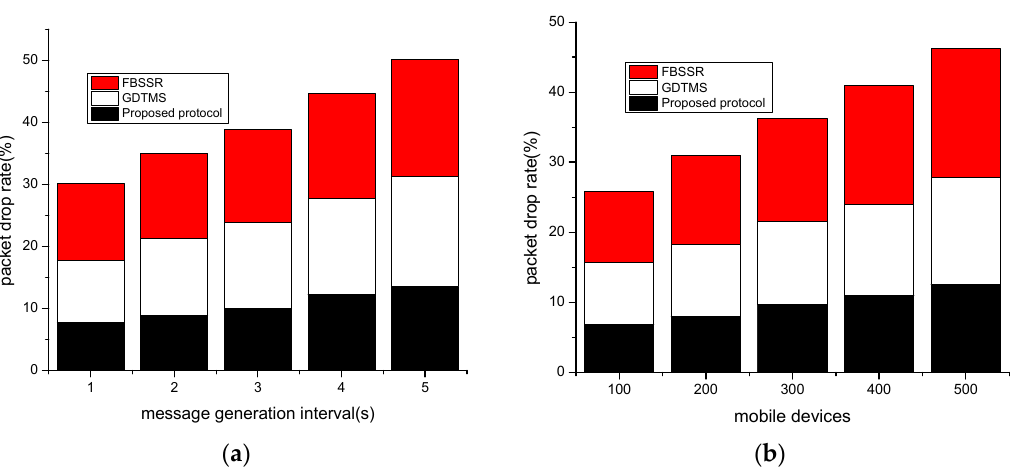
Figure 5. ( a ) Packet drop rate with message generation interval. ( b ) Packet drop ratio with mobile devices.